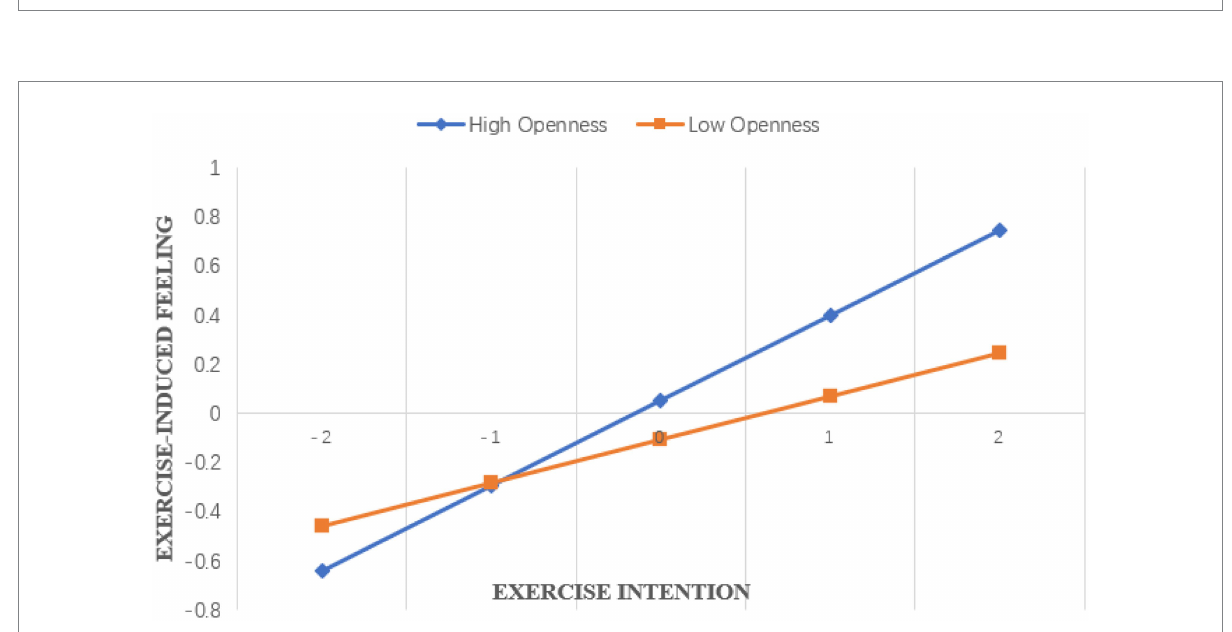
FIGURE 3 The moderating effect of openness on exercise-induced feeling and exercise